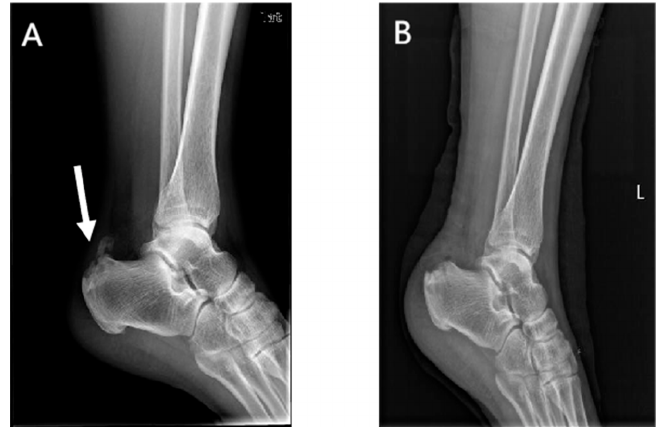
Figure 3. Preoperative ( A ) and postoperative ( B ) lateral radiographs of the ankle in the internal brace group. Arrow, a calcific lesion in the Achilles tendon.